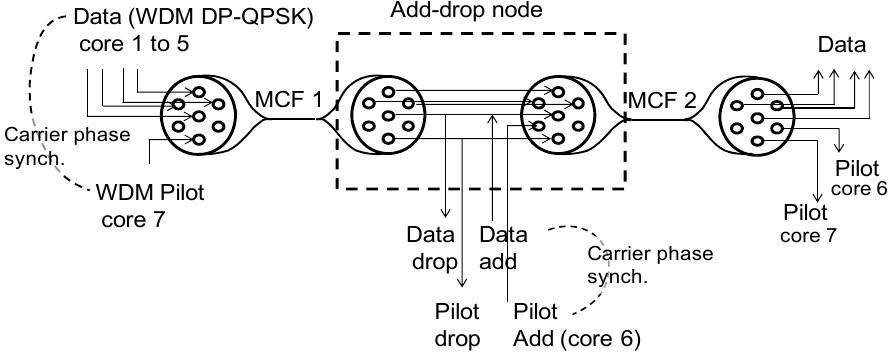
Figure 9. Add and drop in the SDM node with PT. MCF, multi-core